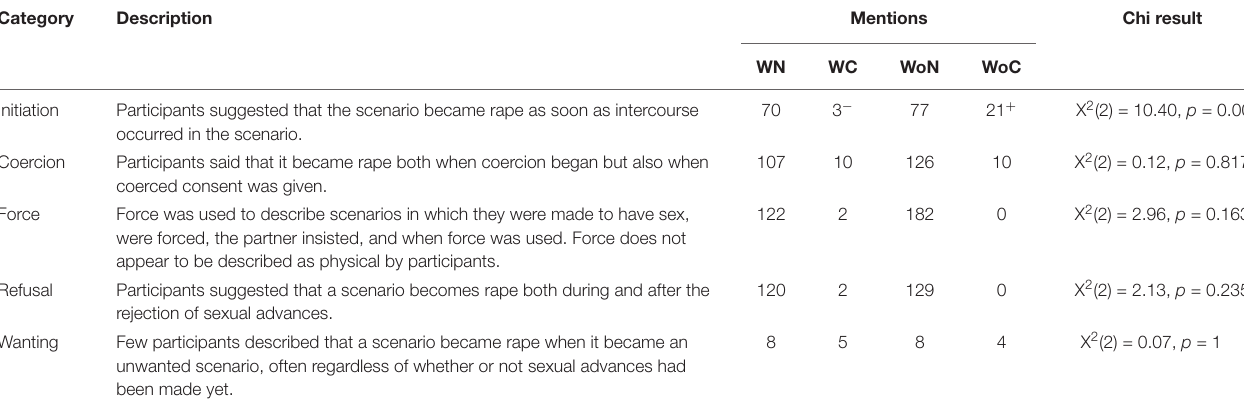
TABLE 3 | Summary content analysis (full analysis presented in Supplementary Table S3 ) for the question “At which point in the scenario do you think It became rape?” Category